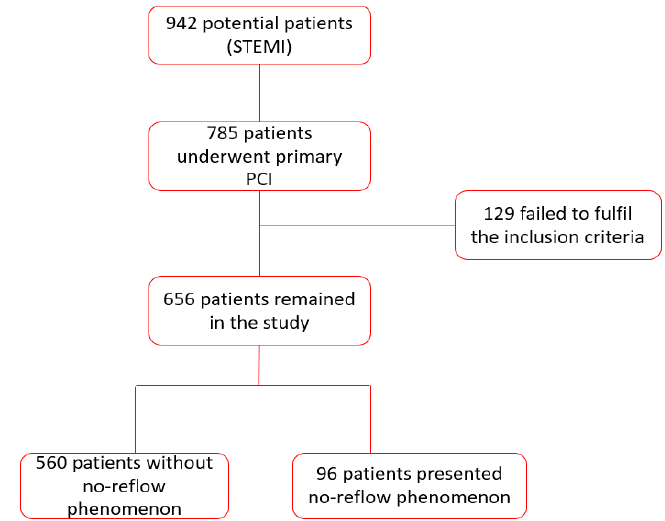
Figure 1. Flow chart describing the way of patient selection (STEMI: ST-segment elevation myocardial infarction, PCI: percutaneous coronary intervention).